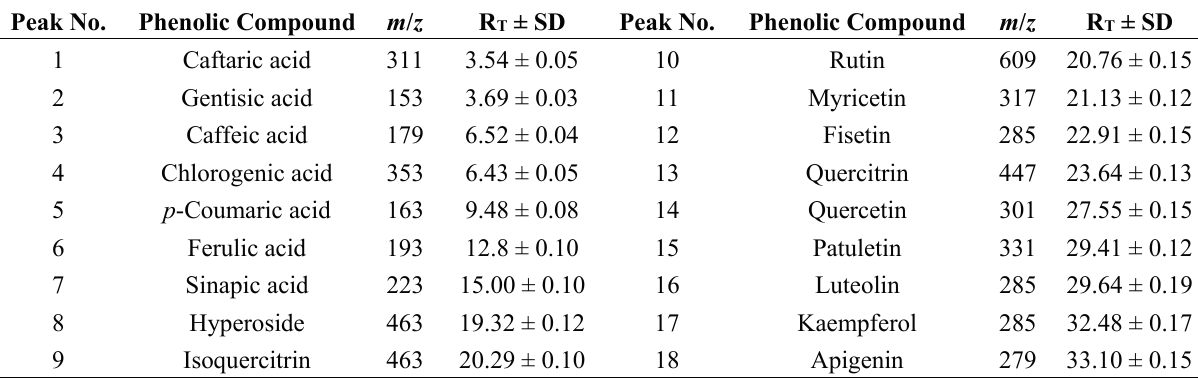
Table 5. Retention times (R T ) of standard polyphenolic compounds